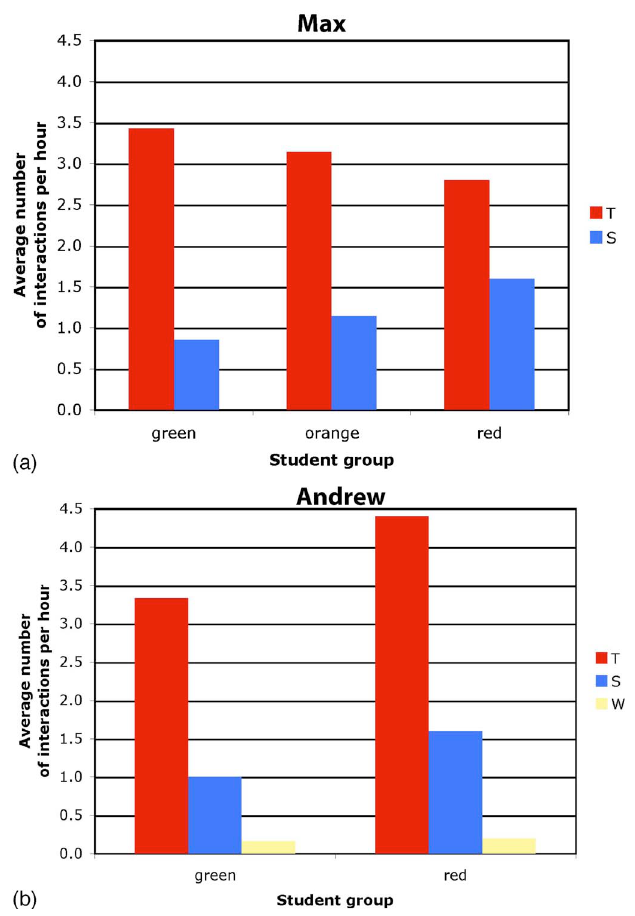
FIG. 6. (cid:1) Color (cid:2) (cid:1) a (cid:2) Max’s interactions with the green, orange, and red student groups. (cid:1) b (cid:2) Andrew’s interactions with the green and red student